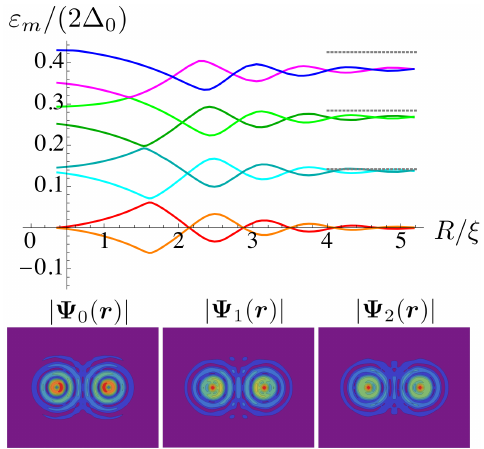
/ 2 normalized by the full gap ∆ m